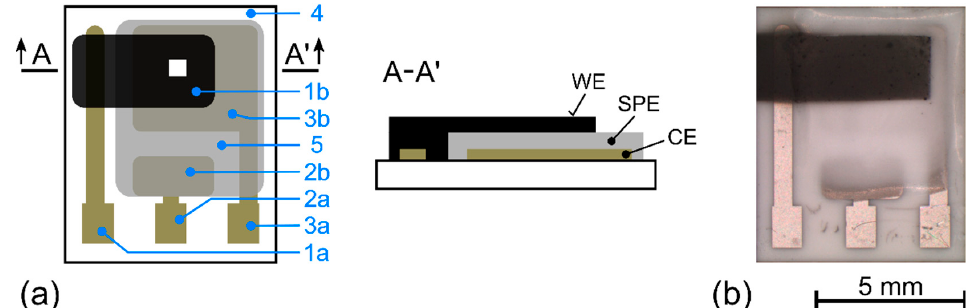
Figure 1. Topology of an amperometric NO 2 sensor ( a ): working electrode contact (1a), carbon working electrode (1b), pseudo-reference electrode contact (2a), pseudo-reference electrode (2b), counter electrode contact (3a), counter electrode (3b), substrate (4), solid polymer electrolyte (SPE) (5), white square indicates the location of Raman spectroscopy measurements of the WE electrode. ( b ) Sensor with MWCNT working electrode and SPE layer treatment 120 °C for 90 s.